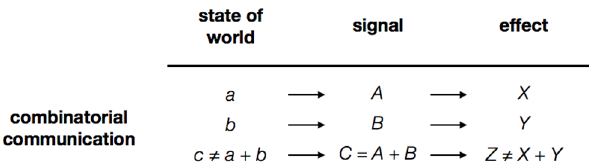
Figure 1. Combinatorial communication. In a combinatorial communication system, two (or more) holistic signals (A and B in this figure) are combined to form a third, composite signal (A + B), which has a different effect (Z) to the sum of the two individual signals (X + Y). Applied to the putty-nosed monkey system, the symbols in this figure would be: a= presence of eagles; b= presence of leopards; c= absence of food; A= ‘pyow’; B= ‘hack’ call; C=A + B= ‘pyow-hack’; X= climb down; Y= climb up; Z ? X + Y= need for group movement (e.g. to forage). Several systems in nature (e.g. the waggle dance of honeybees) have signals composed of two distinct parts, but this composite signal is not different to the sum of the component parts (in the terms of this figure, there is a state of the world c=a + b, with a signal C=A + B and a response Z=X + Y).